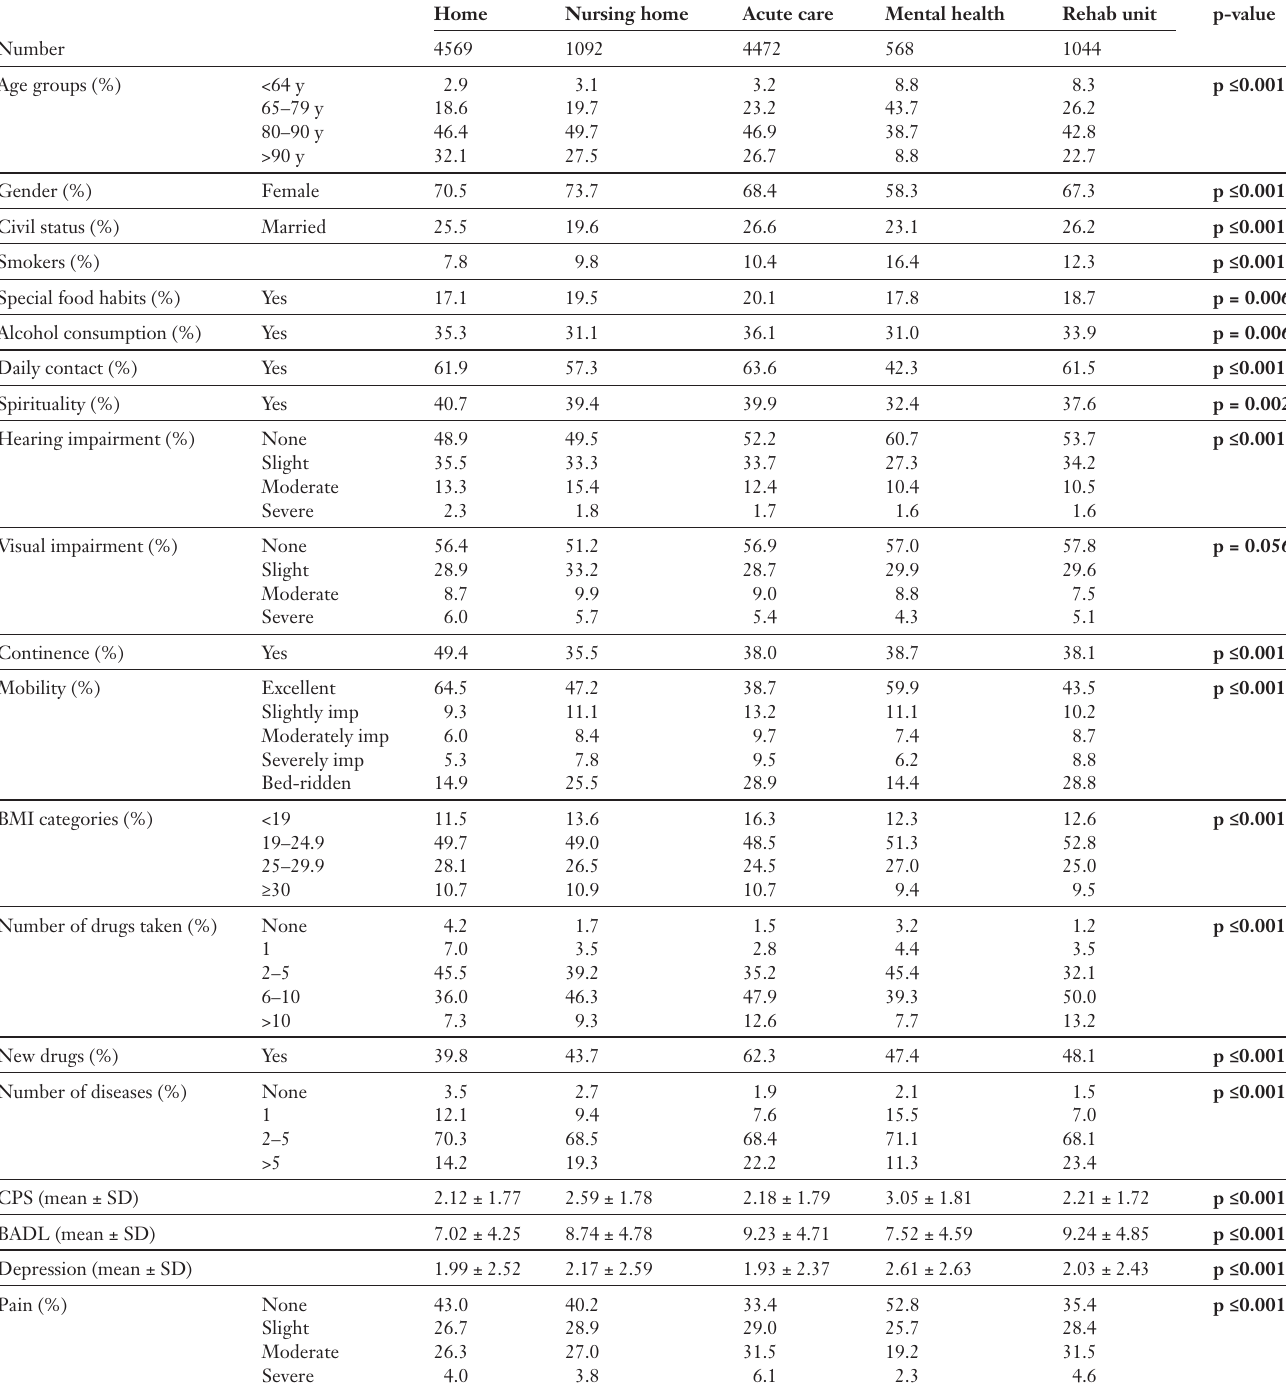
Characteristics of study participants depending on their previous